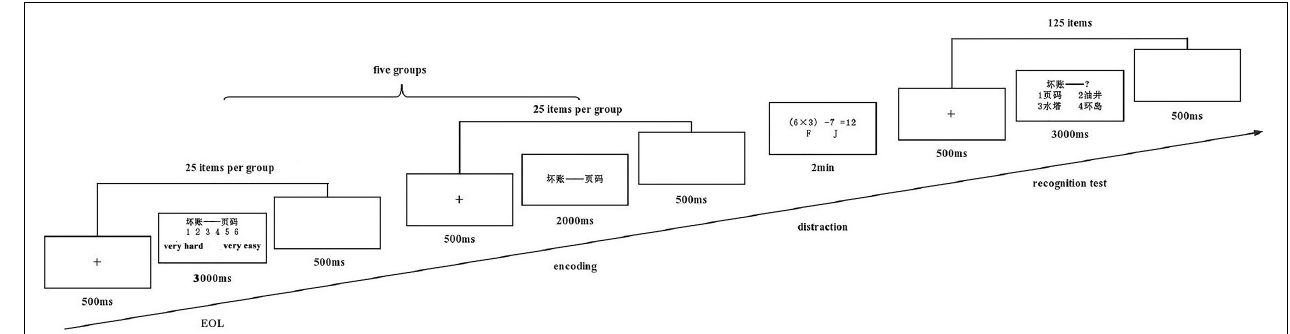
FIGURE 1 | The procedures of the experiment were used in the